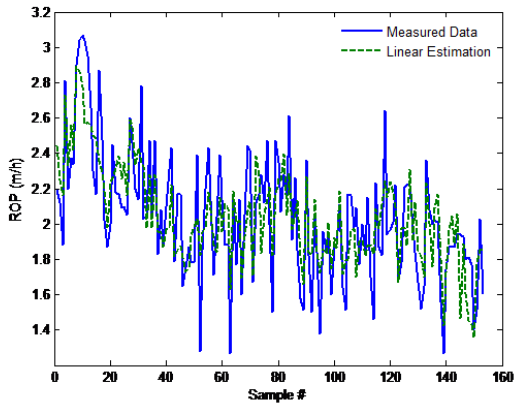
Figure 3: Linear regression